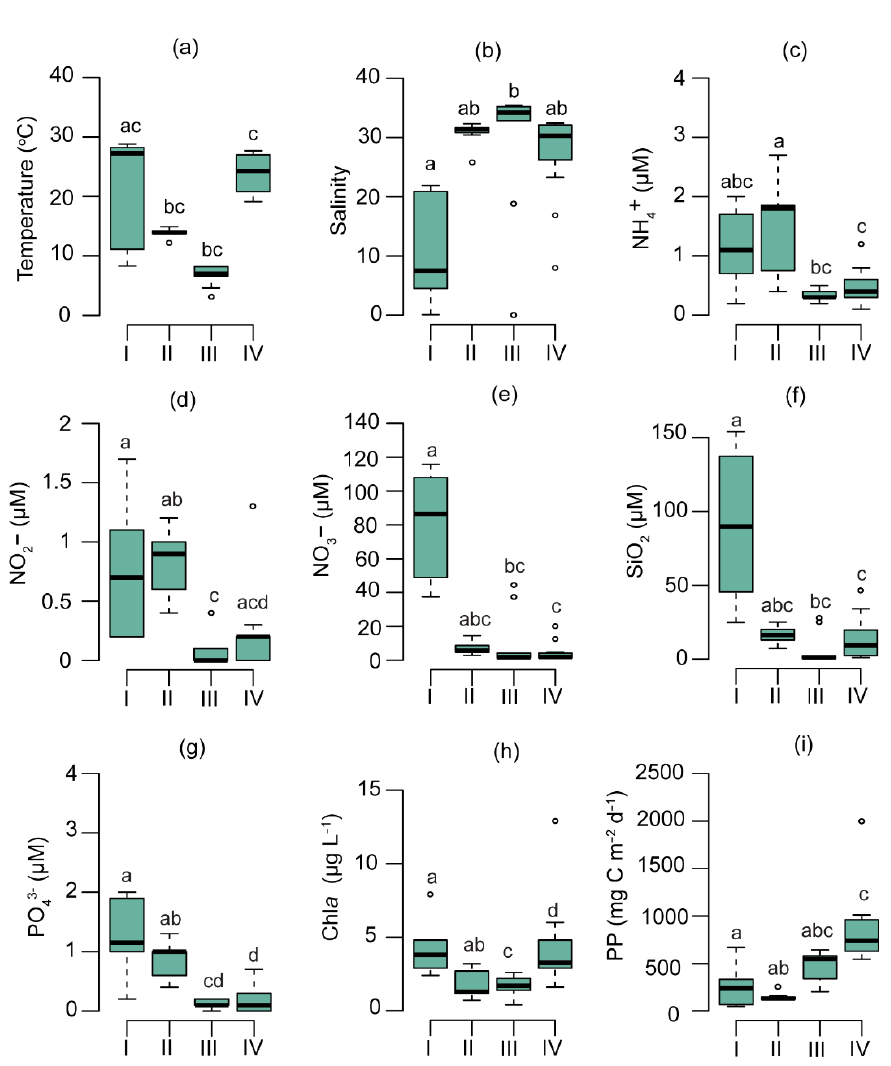
Figure 6. Box and whisker plots showing ( a ) water temperature, ( b ) salinity, ( c ) ammonium (NH 4+ ), ( d ) nitrite (NO 2 − ), ( e ) nitrate (NO 3 − ), ( f ) silicate (SiO 2 ), ( g ) dissolved inorganic phosphate (DIP = PO 4 3− ), ( h ) total Chl a , and ( i ) phytoplankton primary productivity of four clusters. The median value of each cluster is displayed with the horizontal bar inside the box. The same superscripts indicate statistically nonsignificant differences between clusters ( p > 0.05).